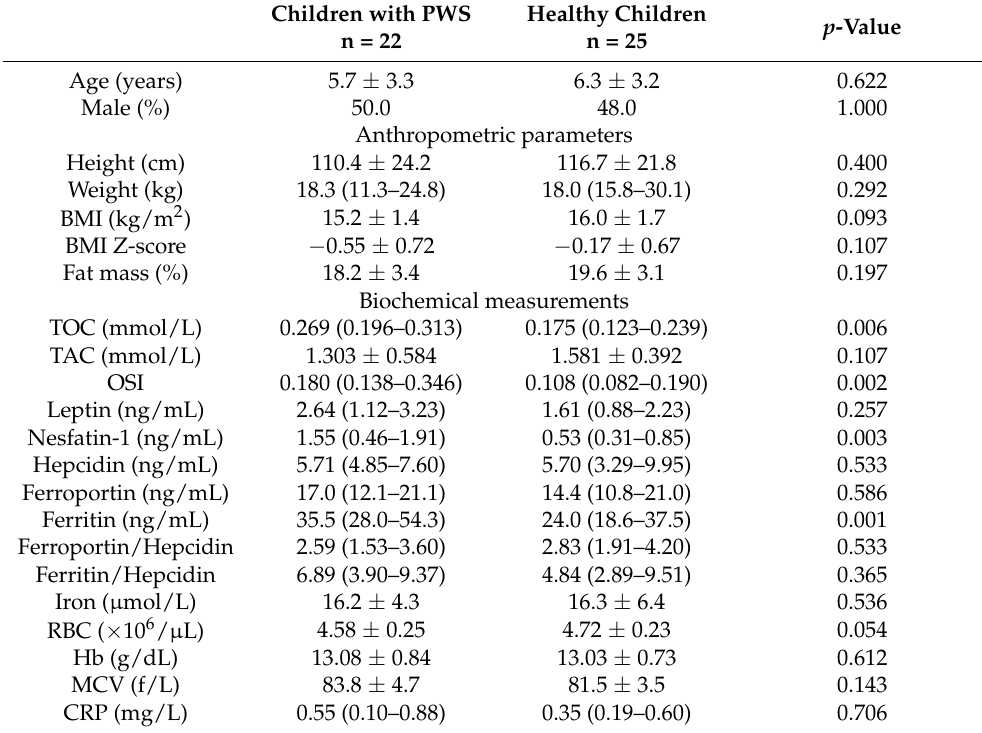
Table 1. Anthropometric and biochemical characteristics of children with PWS and healthy children. Children with PWS n =